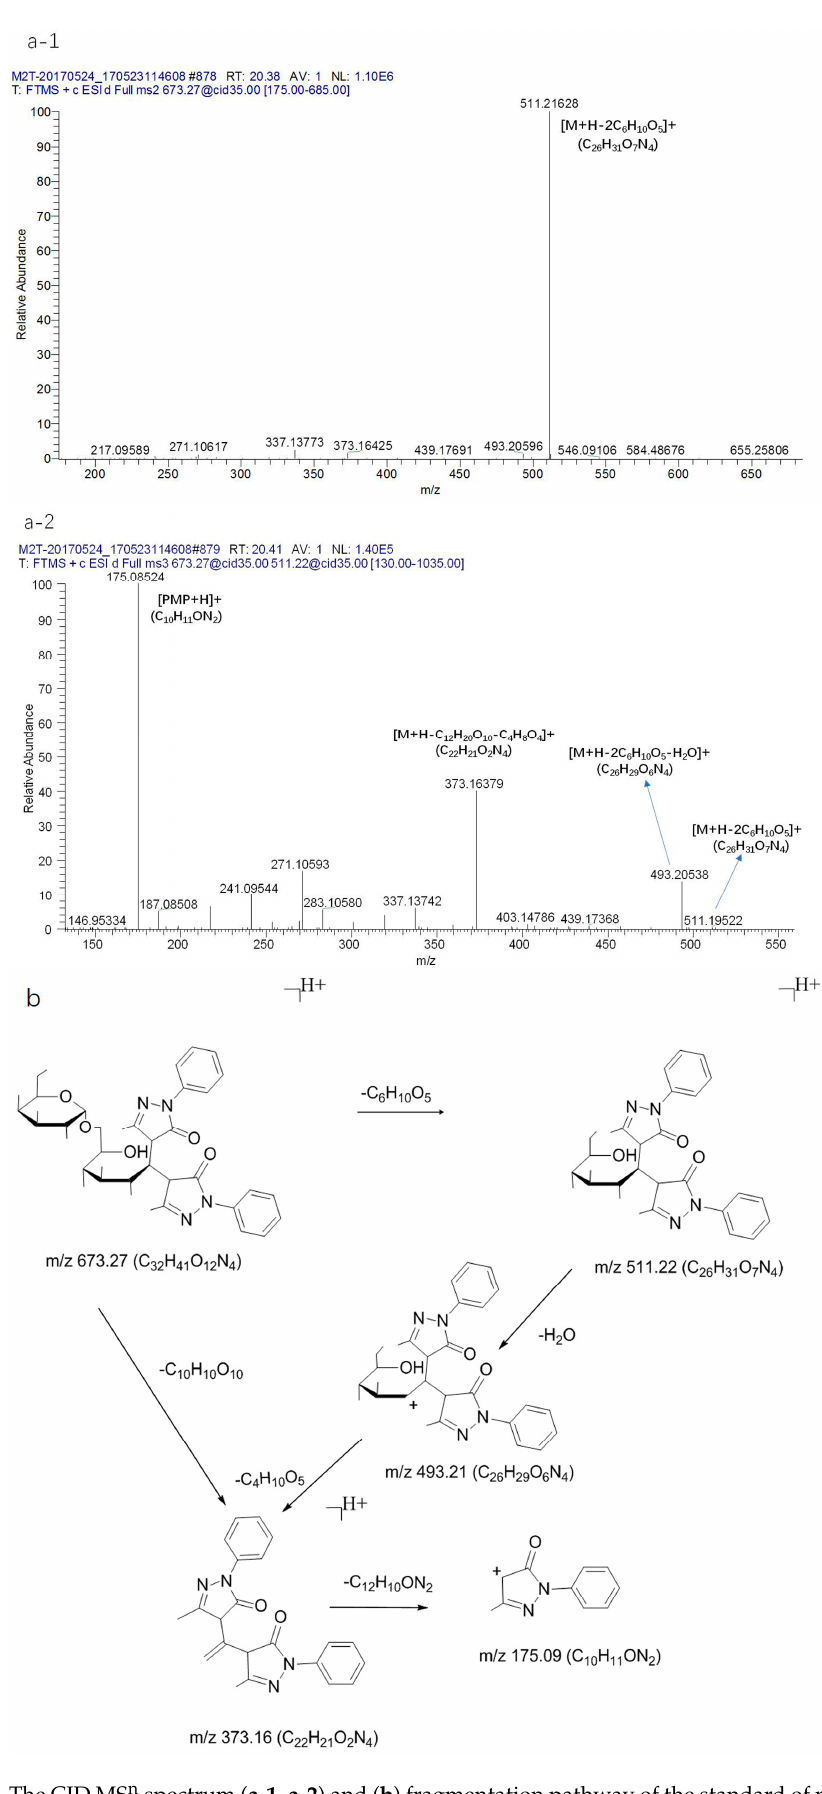
Figure 7. The CID MS n spectrum ( a-1 , a-2 ) and ( b ) fragmentation pathway of the standard of melibiose.